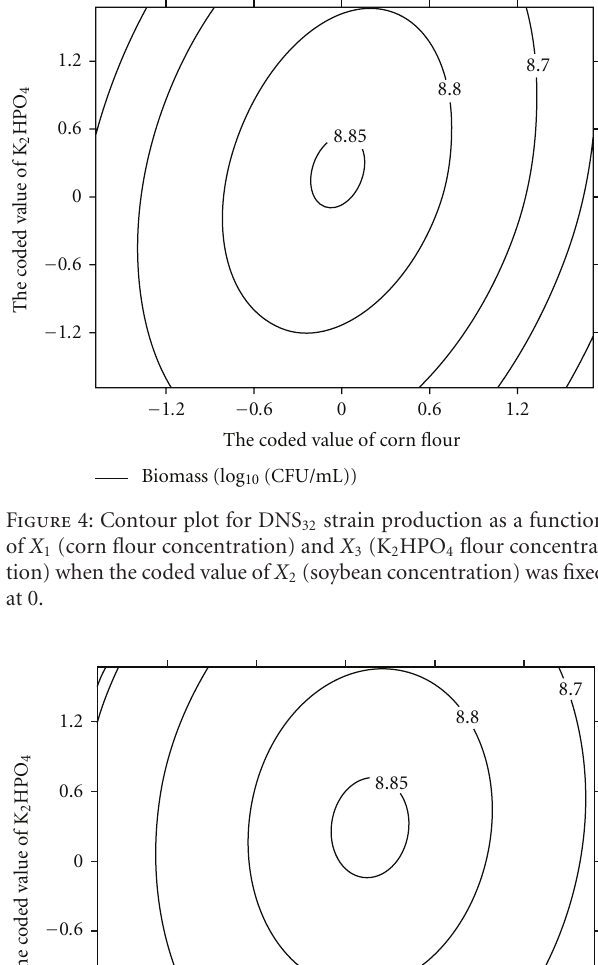
X 3 (K 2 HPO 4 flour concentration)